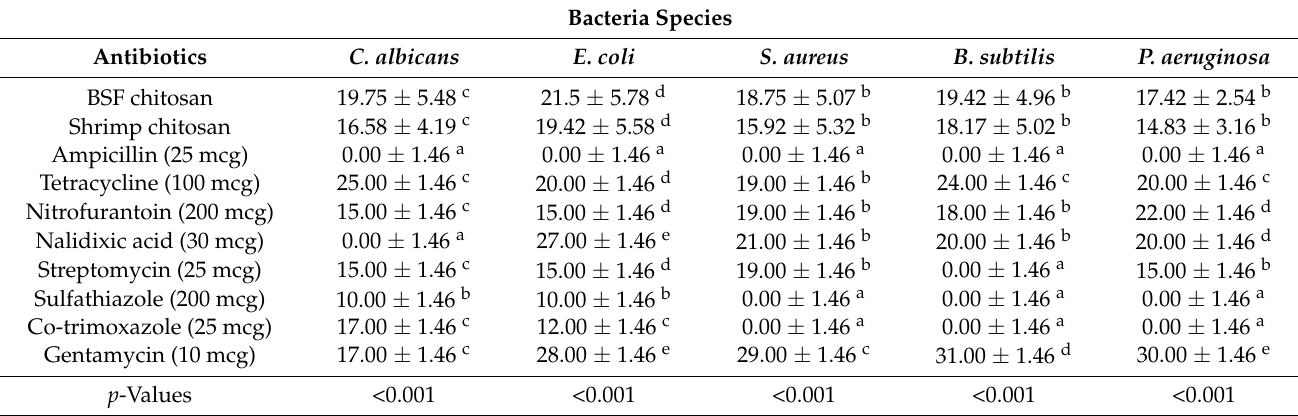
Table 3. Mean inhibition zones (mm) of BSF chitosan, shrimp chitosan, and conventional antibiotics against selected pathogenic